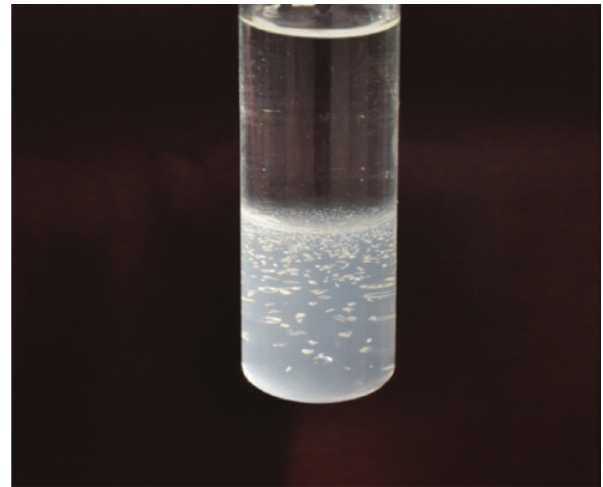
Figure 1: Photograph of the crystalline